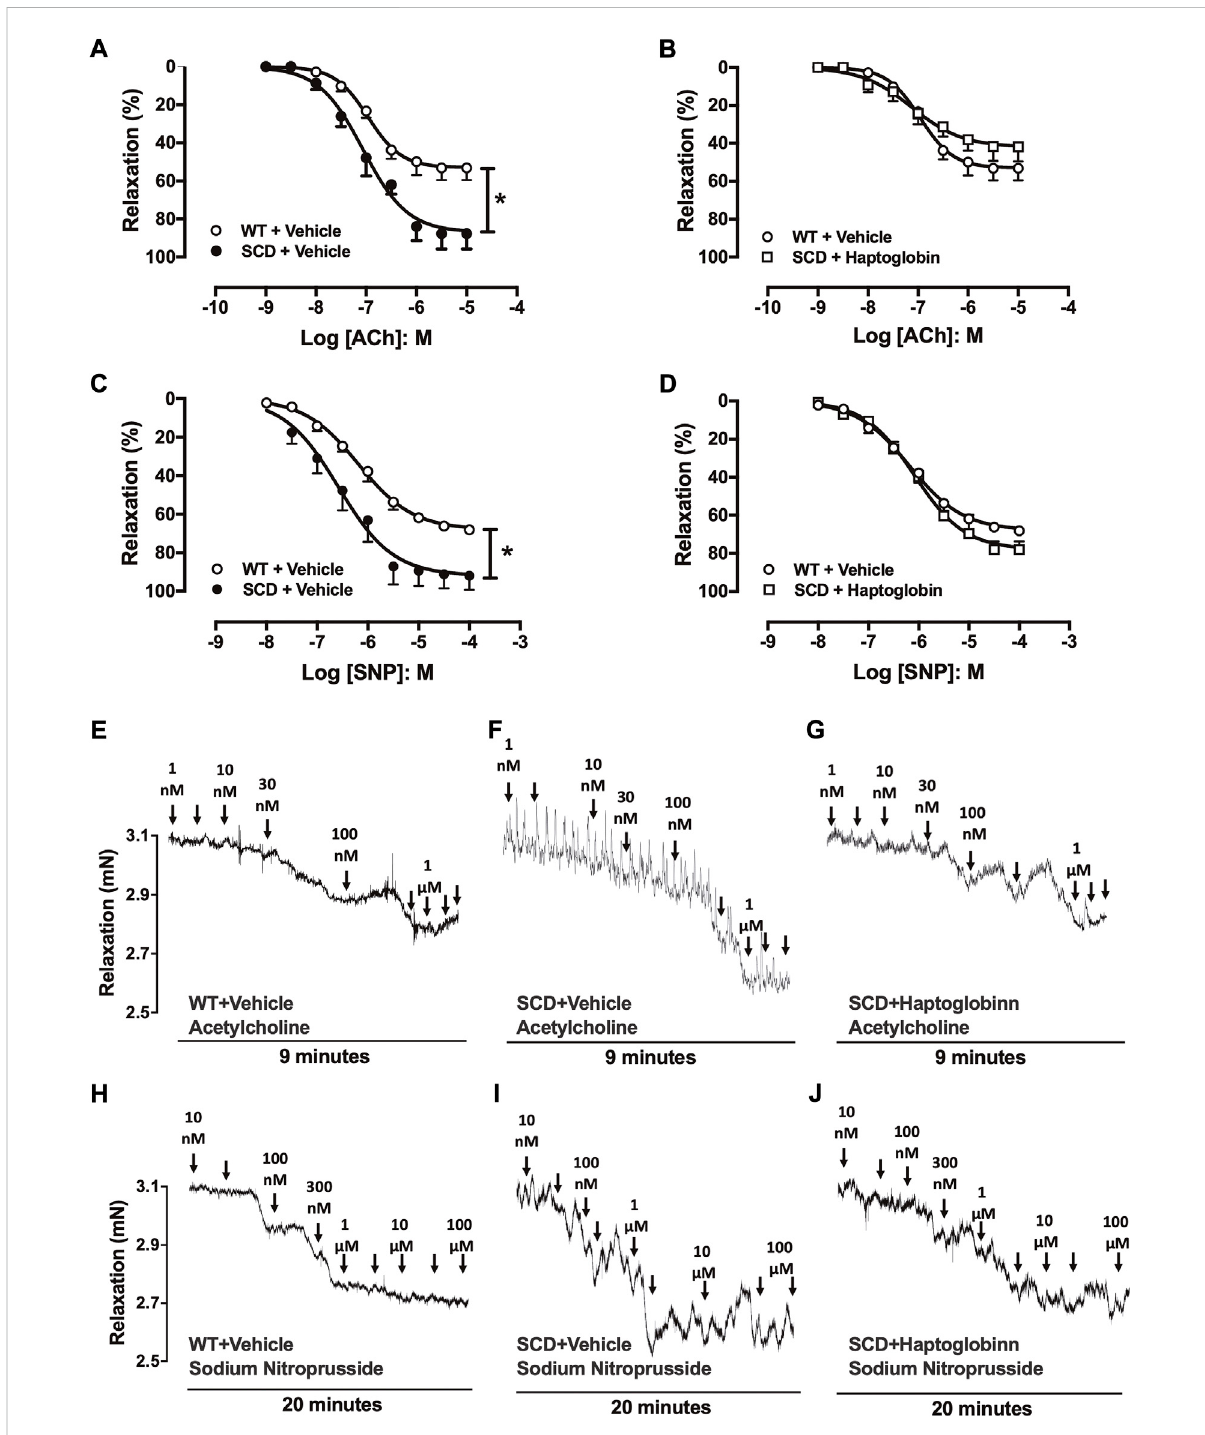
FIGURE 1 Concentration-response curves to acetylcholine [ACh; (A,B) ] and sodium nitroprusside [SNP, (C,D) ] in corpus cavernosum strips from WT and SCD mice treated or not with haptoglobin (Hap). Data were calculated relative to the maximal changes from the contraction produced by phenylephrine(10 – 5 M) in each tissue, which was taken as 100%. Data represent themean ± SEM for 6 mice in each group. * p < 0.05 vs. WT-Vehicle; # p < 0.05 vs. SCD-Hap. Representative tracings of relaxant response to ACh (E – G) and SNP (H – J) in corpus cavernosum strips from WT and SCD mice treated or not with